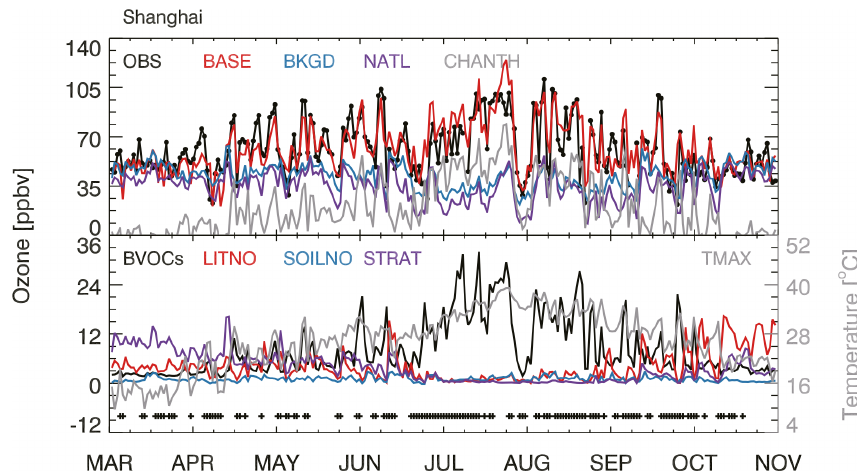
Figure 8. Same as Fig. 7 but for